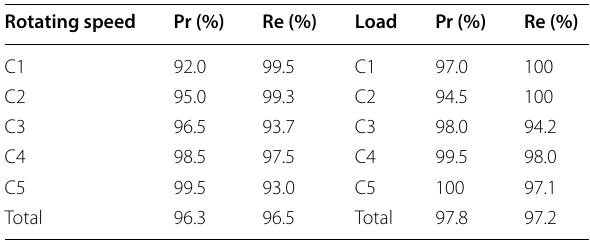
Table 5 NMF‑based co‑clustering results for fault type recognition ( k 6) = Rotating speed